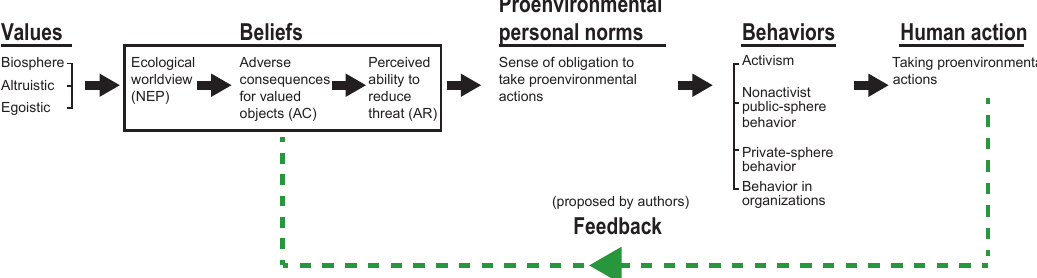
Figure 2. Value–belief–norm (VBN) theory. Adapted from Ives and Kendal (2014) and Stern (2000). The feedback (green arrow) from communal behavior to individual beliefs is introduced here by the authors to recognize that it has indeed been included in recent SH studies in preliminary ways (van Emmerik et al., 2014, Elshafei et al., 2014, and Roobavaanan et al., 2017) and needs to be formalized in future